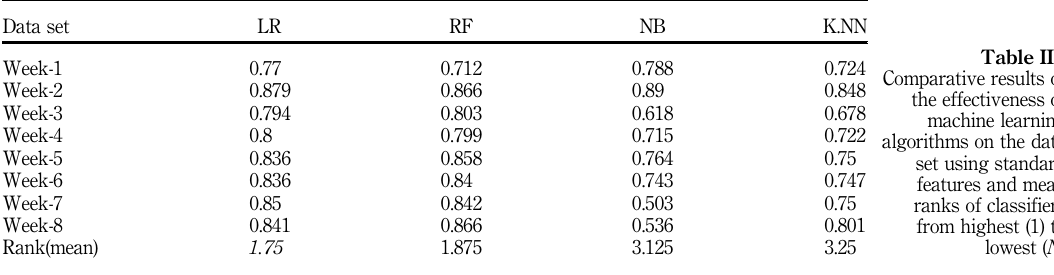
Table III. Comparative results